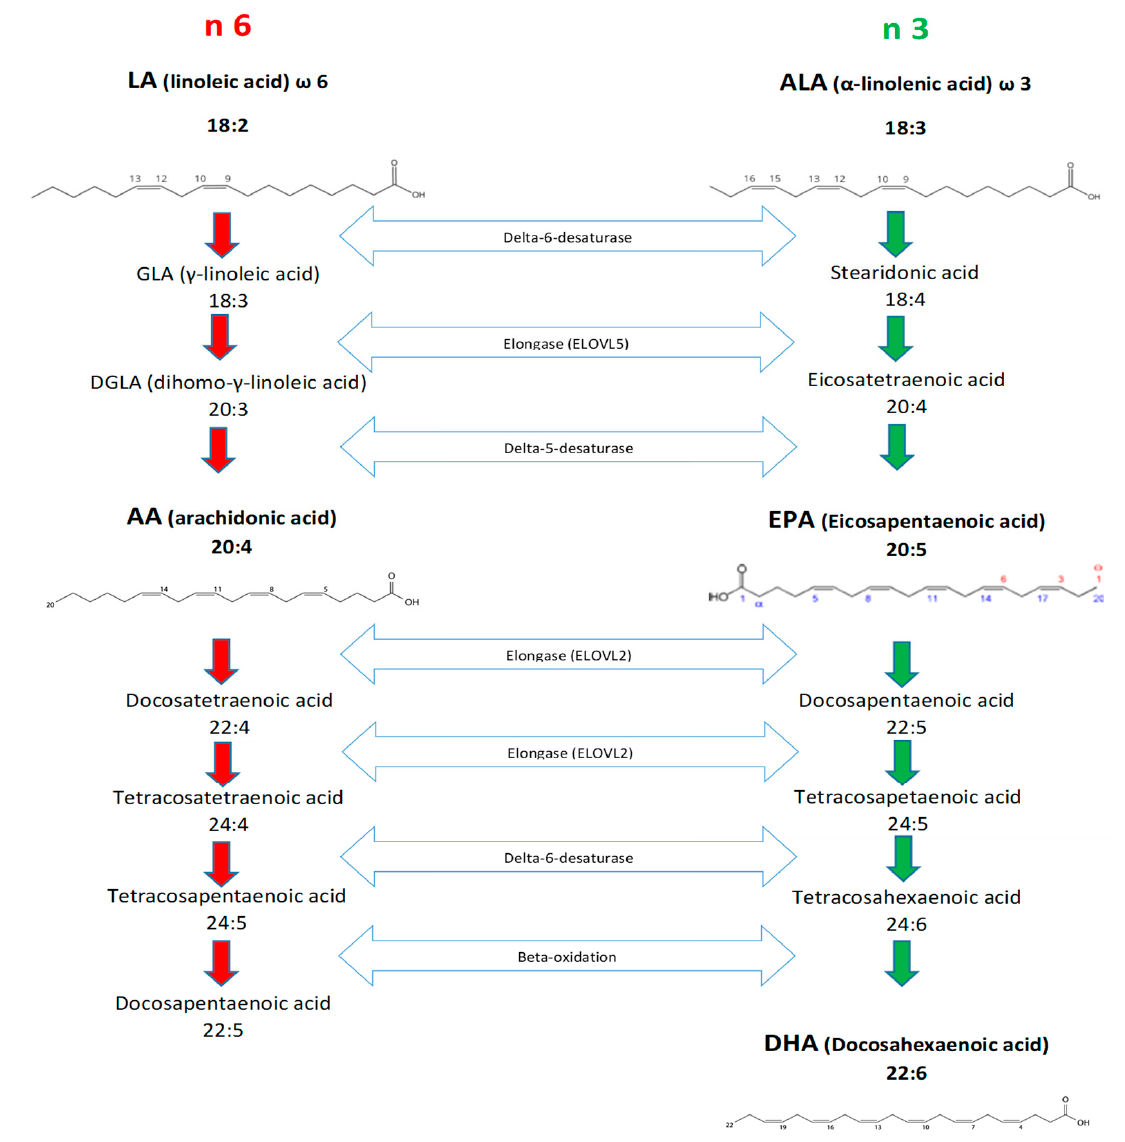
Figure 2. Metabolic pathways of n-6 and n-3 PUFA. The red arrows indicate the synthesis of n-6 and the green arrows the synthesis of n-3. The double blue arrows represent the enzymatic pathway.